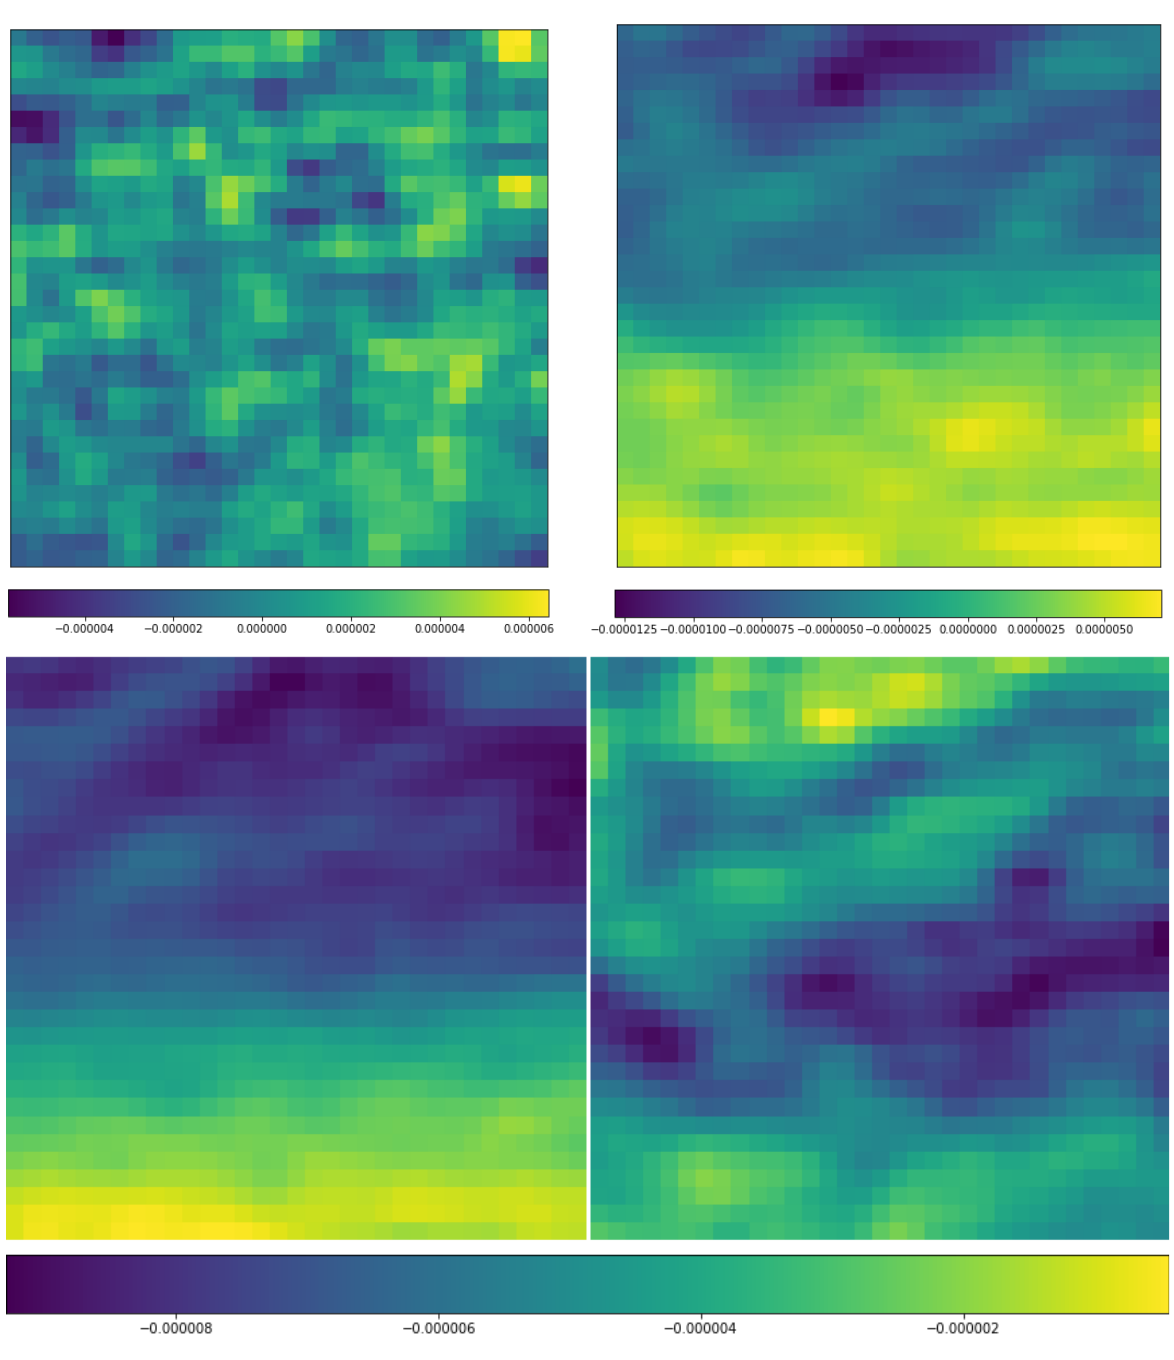
Figure 10. Distribution of mean vorticity (relative, vo) and differences (unit: s − 1 ) for the 584 RI cases and randomly selected 584 non-RI samples: differences between the RI and non-RI means at 850 hPa ( upper left ), 300 hPa ( upper right ), and the value distribution for RI ( bottom left ) and non-RI ( bottom right ) at 300 hPa. The X-axis and Y-Axis are aligned as in Figure 8.